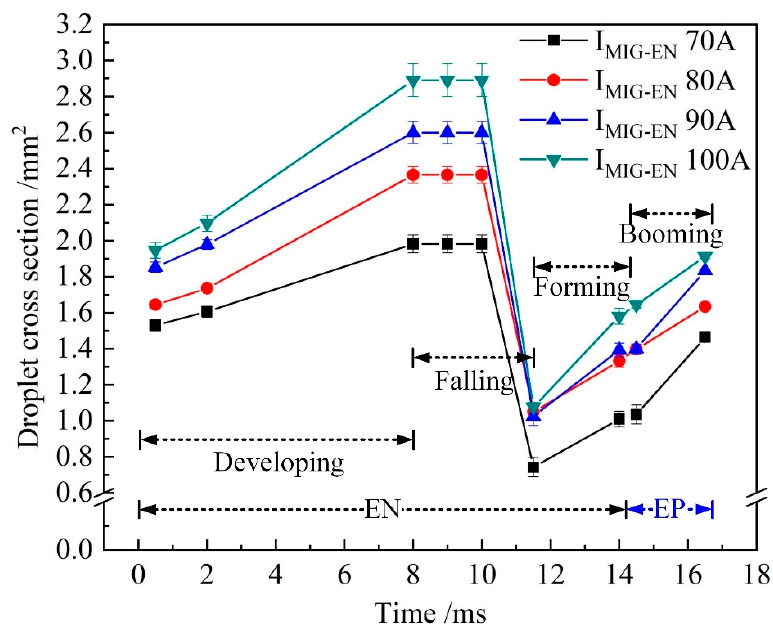
Figure 11. The evolution of droplet cross-sectional area when I MIG-EN is increased and I VPPA-EN is maintained at 50 A.